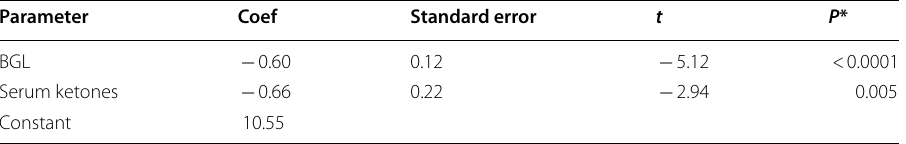
*Statistical significance ( P < 0.05)